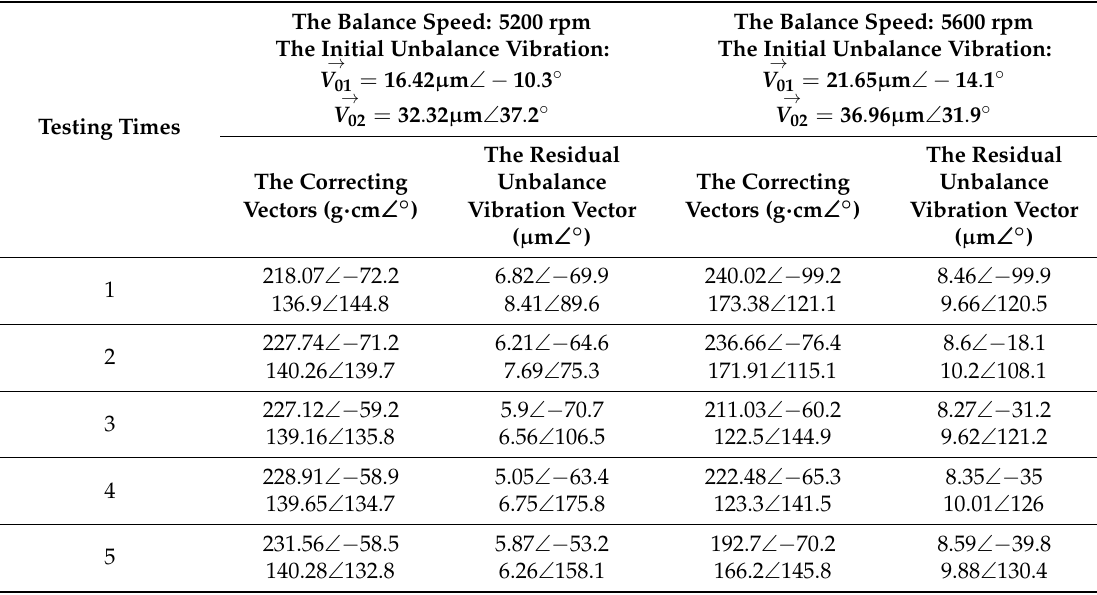
Table 4. The other experimental